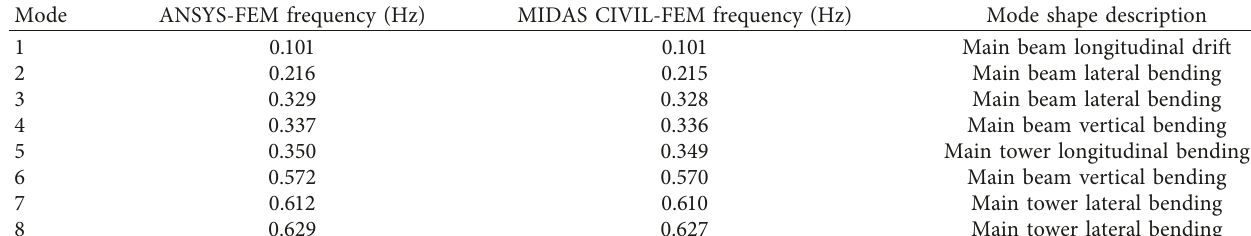
Table 2: Niutianyang Bridge dynamic characteristics.